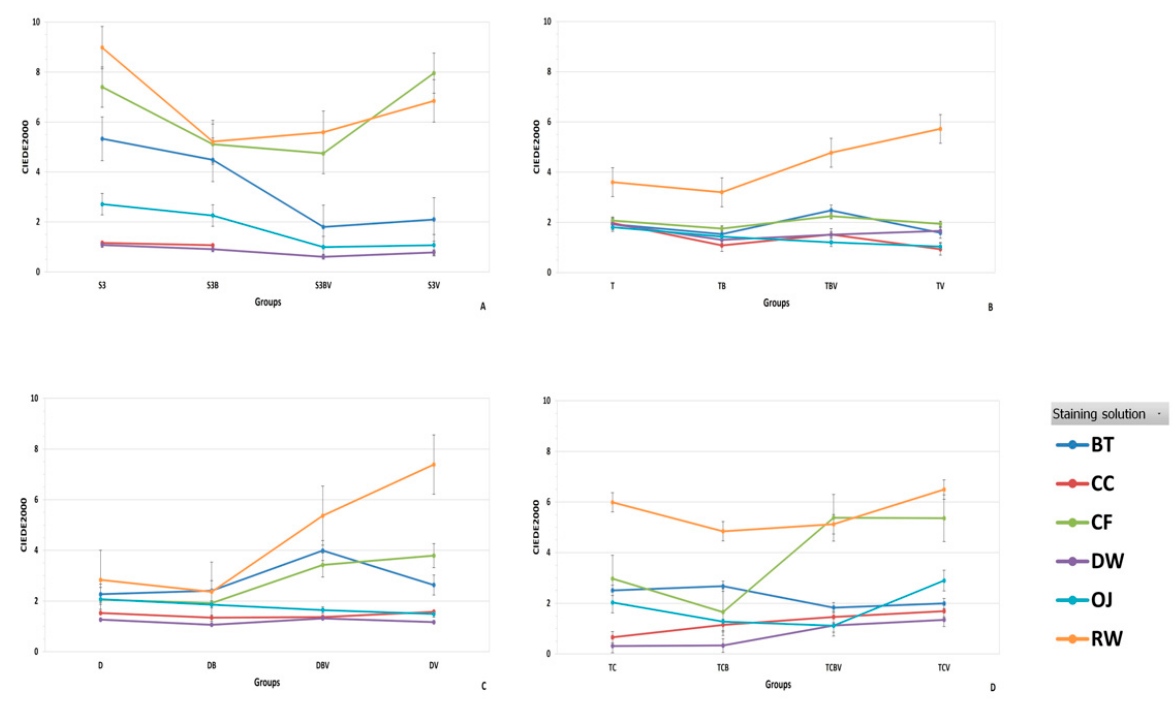
Figure 2. Mean ∆ E 00 (T1, T2, and T3) interaction for each group and different staining solution: ( A ) bis-acryl (Structur 3); ( B ) PEMA (Trim); ( C ) PMMA (DuraLay); and ( D ) PMMA blocks for CAD/CAM (TelioCAD).